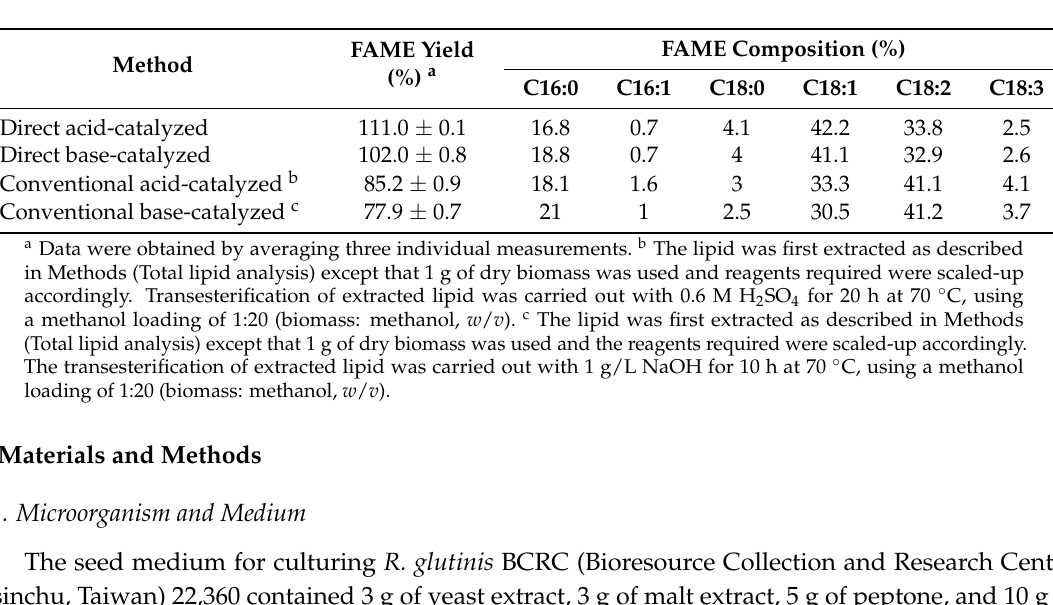
Table 1. YieldsandcompositionsofFAMEderivedfrom R.glutinis